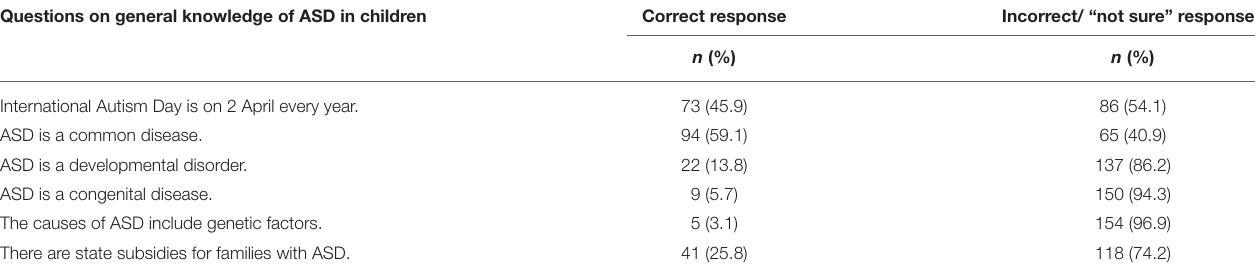
TABLE 2 | Participants’ general knowledge of ASD in children. Questions on general knowledge of ASD in children Correct response